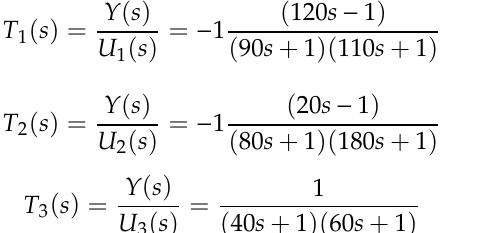
Figure 9. GPC with the 9th order internal model—closed loop simulation of 300 time-steps, trend for MVs signals. Controller parameters: control horizon N u = 20, prediction horizon N = 400, and the R matrix = identity matrix